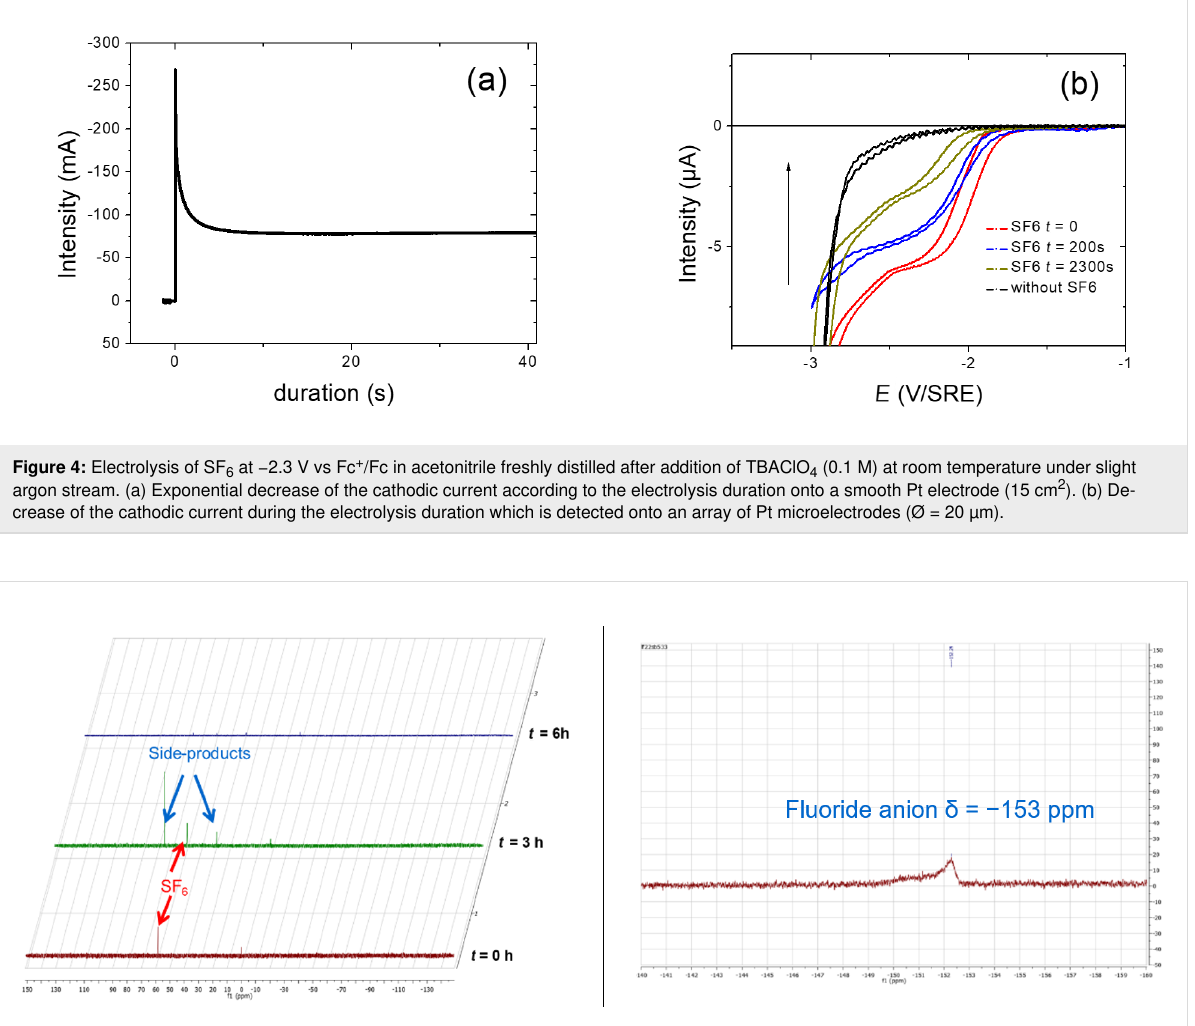
Figure 5: 19 F NMR evolution of the crude mixture along the time after electrolysis realized at constant potential of − 2.3 V/SRE; (left). 19 F NMR expan- sion of the final mixture.